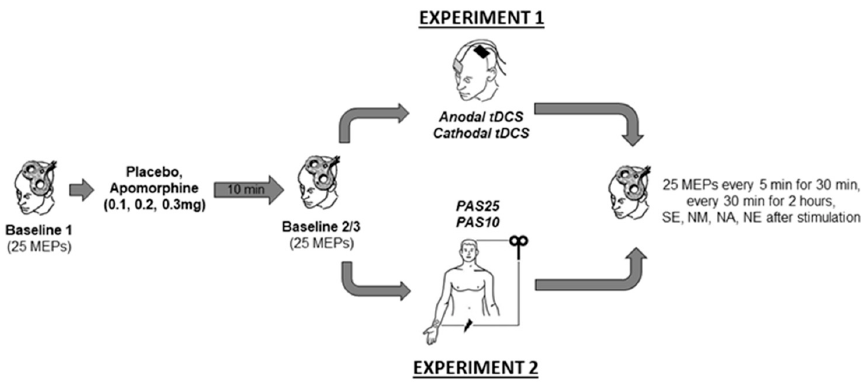
Figure 1. Time course of the experiments. Single-pulse TMS-evoked MEPs over the right ADM motor hotspot were recorded at intensities that evoked 1mV MEP amplitudes before drug injection (Baseline 1). Baseline 2 was recorded ten minutes after drug injection to look for drug-induced changes of cortical excitability. In case of any MEP alterations from baseline 1, Baseline 3 was recorded by adjusting the stimulator output to obtain a mean MEP amplitude of 1 mV. Then tDCS (anodal or cathodal) in Experiment 1 or PAS (PAS25 or PAS10) in Experiment 2 was administered, immediately followed by MEP after-measurements covering 120 min. Additional after-measurements were performed at the same evening (SE) and the morning at approximately 9:00 AM (NM), noon, at approximately 12:00 PM (NN), and evening, at approximately 6:00 PM (NE) of the second day after plasticity induction. Motor evoked potential (MEP). Transcranial direct current stimulation (tDCS). Paired associative stimulation (PAS).